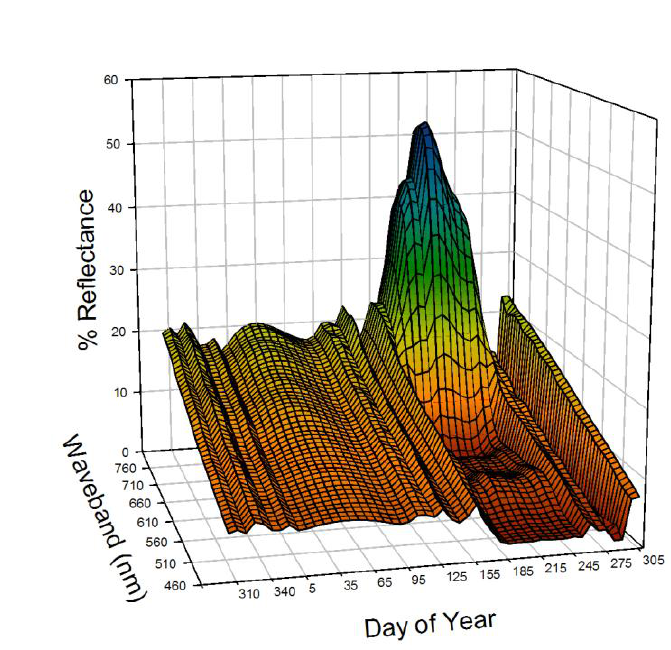
Figure 2. Reflectance over corn obtained throughout the year with a CropScan eight-band radiometer over a spring strip tillage system in